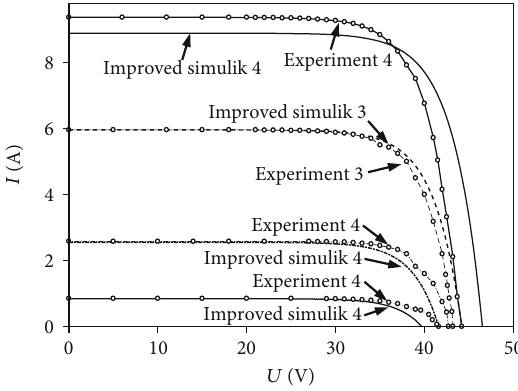
Figure 4: Improved mathematical model and experimental data.